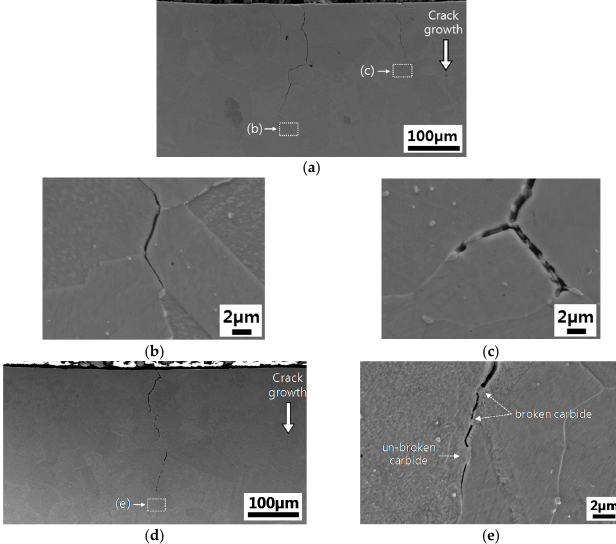
Figure 5. SEM photos of cracks found at the ID surface of ‘Rod’ specimen after 100 h exposure: ( a ) Low magnification photo of crack; ( b ) Enlarged photos of left crack tips in ( a ); ( c ) Enlarged photos of right crack tips in ( a ); ( d ) Low magnification photo of crack; ( e ) enlarged photos of crack tips in ( d ).